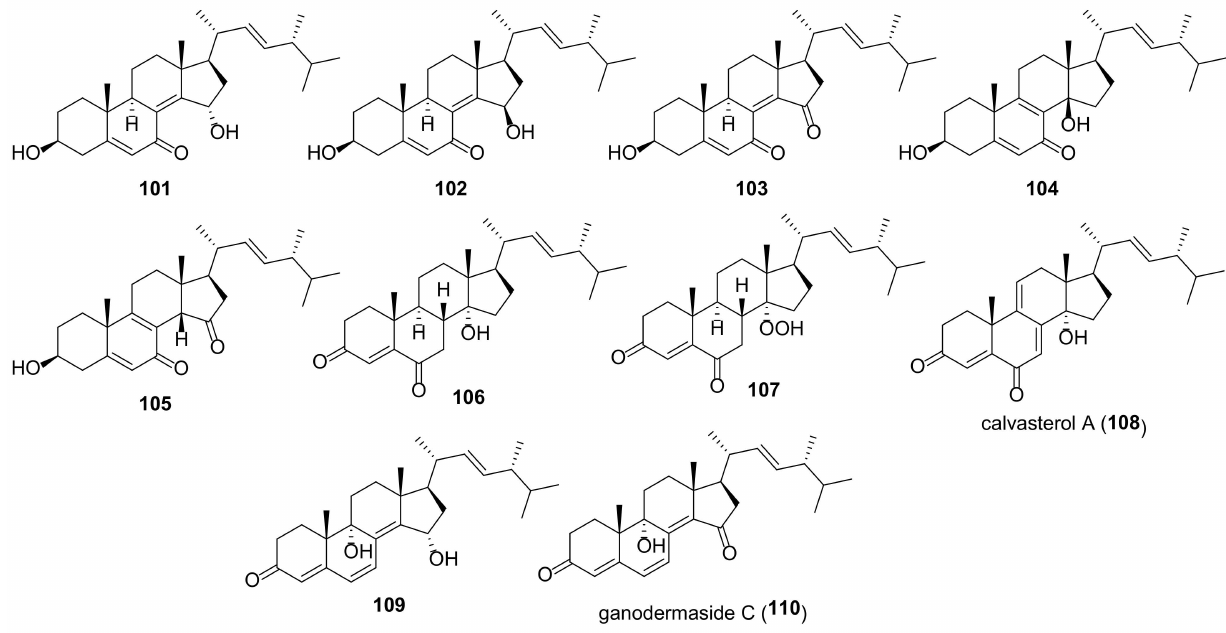
Figure 12. Structures of fungal hydroxyketones with three functional